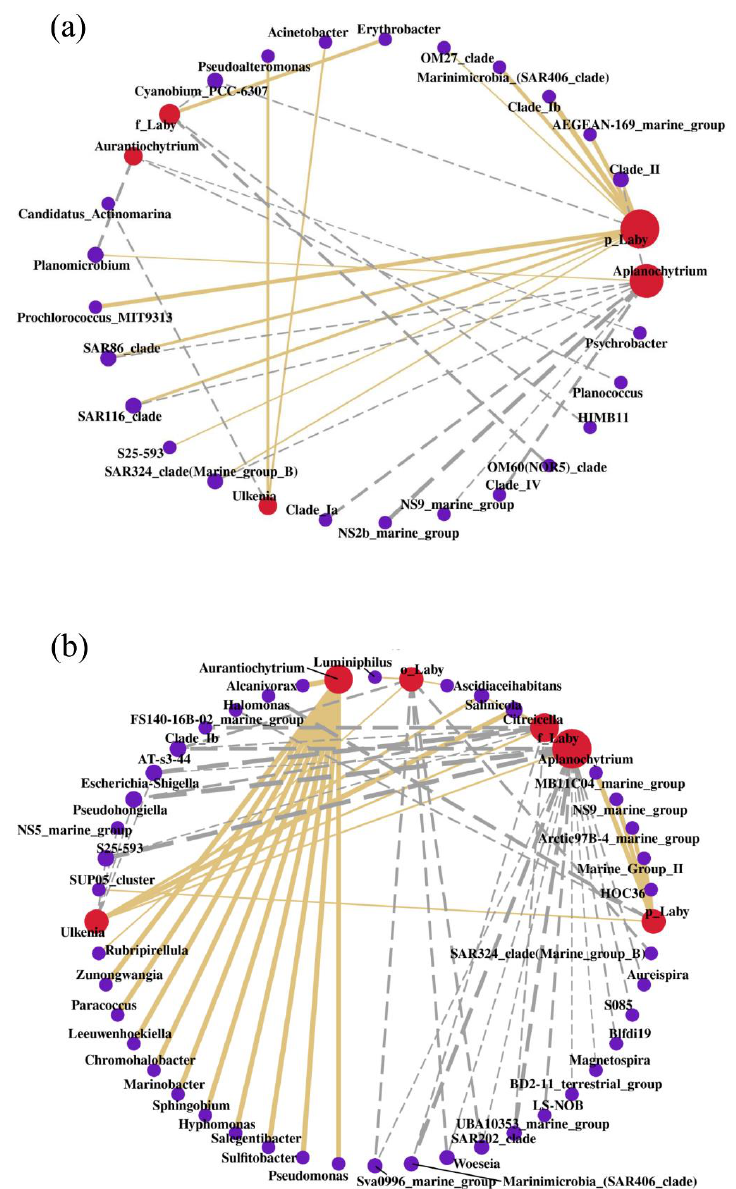
Figure 6. Cooccurrence network of: ( a ) surface; and ( b ) bottom Labyrinthulomycetes and bacteria. Red circles represent genera of Labyrinthulomycetes, and purple circles represent genera of bacteria, with larger dots representing a greater number of related objects. The brown solid line represents positive correlation, and the grey dashed line represents negative correlation—the thicker the line, the stronger the correlation surface layer and ( b ) bottom layer.